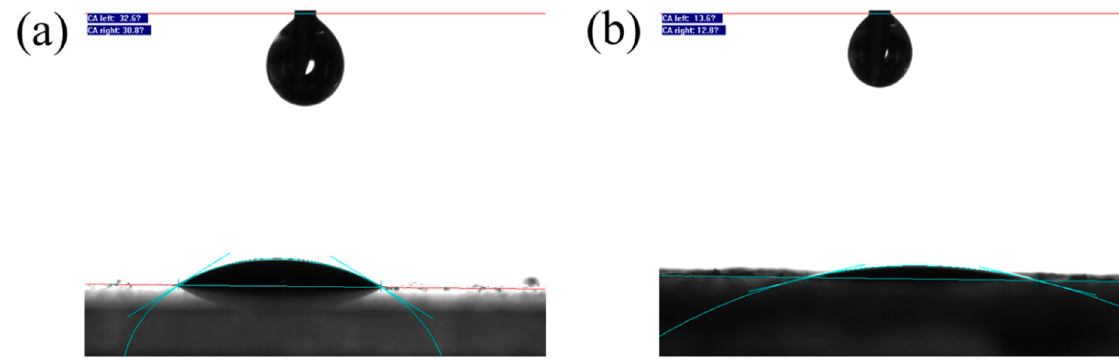
Figure 5. ( a , b ) are static contact angle test images of AgNW and AgNW@ZnO with epoxy. Table 1. Static contact angles of AgNW and AgNW@ZnO with epoxy. Filler